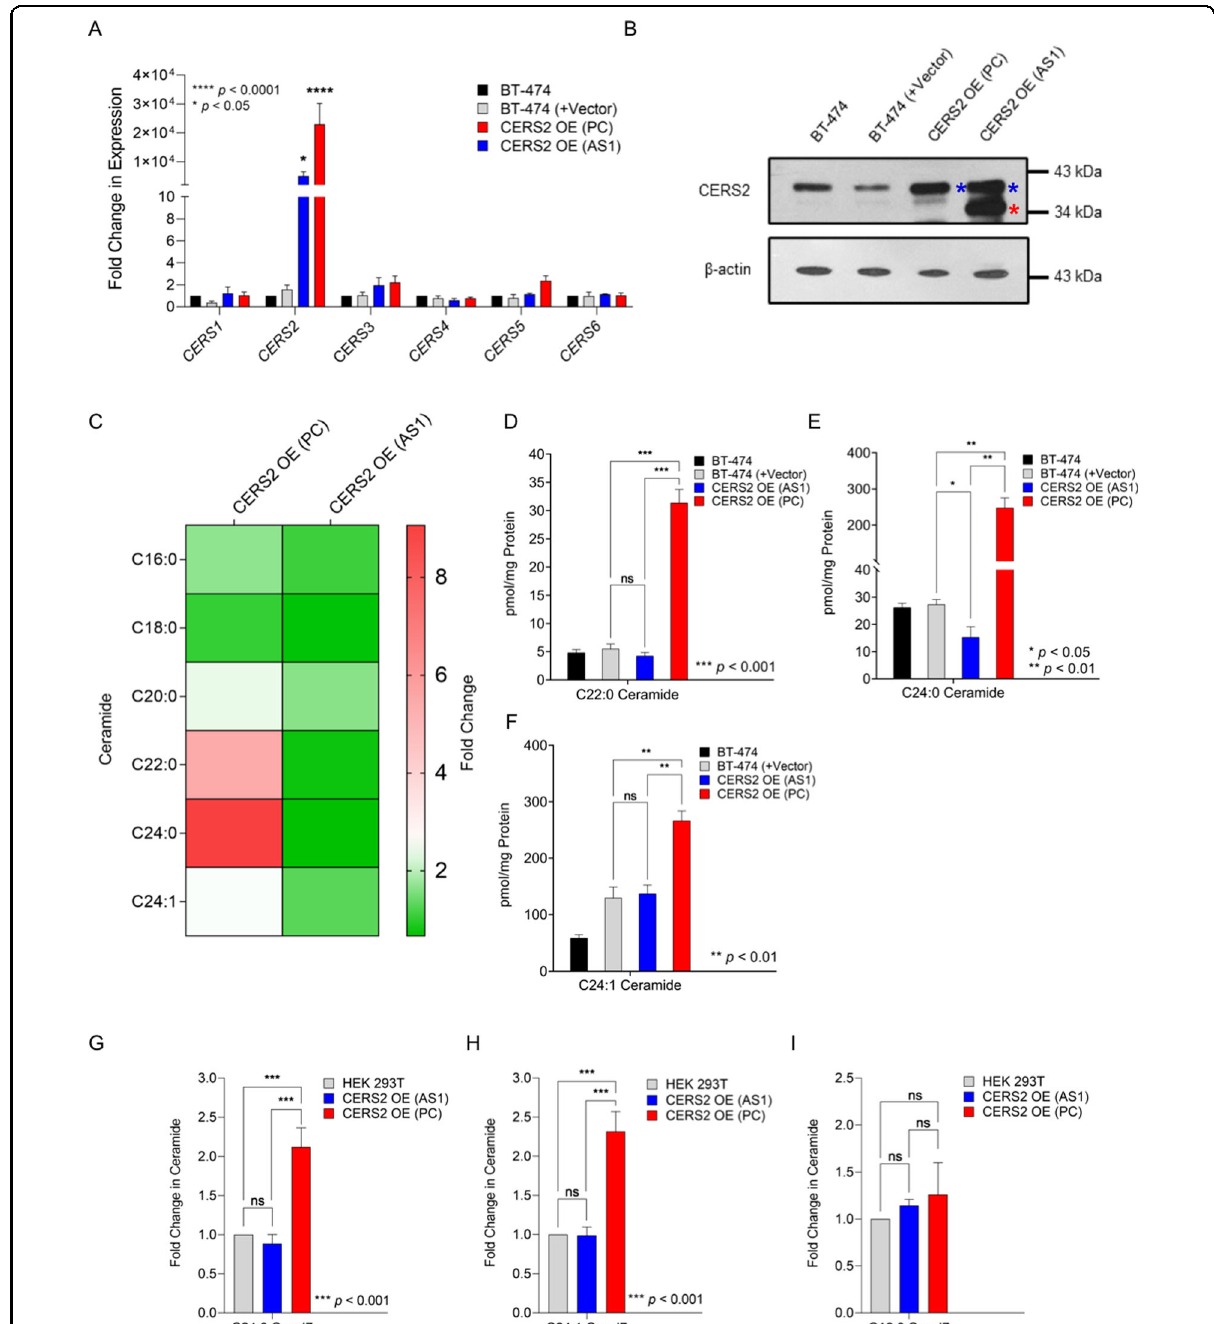
Fig. 6 Overexpression of CERS2 transcript (AS1) decreases expression of very-long-chain ceramides in BT-474 cells. A Change in expression of all ceramide synthases ( CERS1-6 ) (mean ± SD, n = 4) in BT-474 cells transfected with empty vector, BT-474 ( + Vector), full-length protein-coding CERS2 OE (PC), and alternatively spliced transcript coding CERS2 OE (AS1) constructs. Expression was normalized to β -actin. B Immunoblot showing the expression of CERS2 in BT-474, BT-474 ( + Vector), CERS2 OE (PC), and CERS2 OE (AS1) cells by western blot analysis. Protein corresponding to PC transcript is marked by blue asterisk, and to AS1 transcript by red asterisk. C Heat map showing the average fold change in levels of ceramides (C16:0, C18:0, C20:0, C22:0, C24:0, and C24:1) in BT-474 cells transfected with CERS2 OE (PC) and CERS2 OE (AS1) with respect to BT-474 cells. D – F Absolute quanti fi cation of ceramides (mean ± SD, n = 4) show signi fi cant decrease in C22:0 ( D ), C24:0 ( E ), and C24:1 ( F ) ceramides in CERS2 OE (AS1) cells as compared to CERS2 OE (PC) cells. G – I Fold change (mean± SD, n = 4) in deuterium-labeled ceramides (pmol/mg protein) in HEK 293T cells transfected with CERS2 OE (PC) and CERS2 OE (AS1) constructs using HEK 293T cells as a control shows signi fi cant decrease in C24:0 Ceramide (Cer)- d7 ( G ) and C24:1 Cer-d7 ( H ) ceramides with no signi fi cant change in C16:0 Cer-d7 ( I ) ceramides in CERS2 OE (AS1) cells as compared to CERS2 OE (PC) cells. Data in A , D – I were analyzed using ANOVA